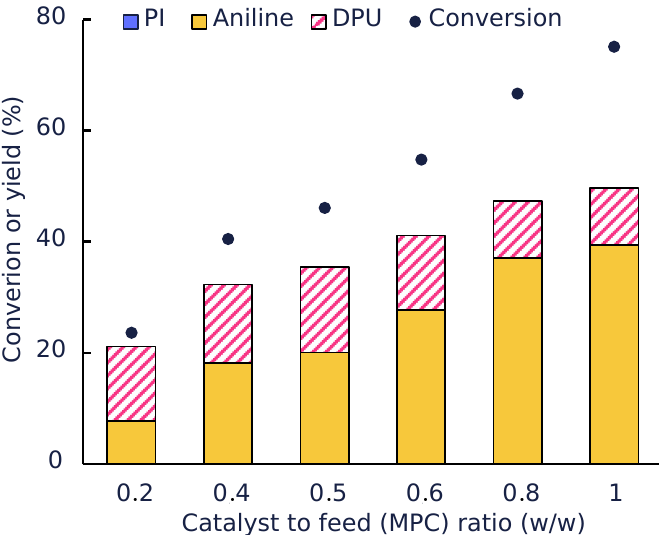
Figure 5. Conversion and yield of products obtained in the autoclave tests conducted with MMK-10 as the catalyst (8 wt% MPC in Diphenyl ether at 200 °C and 1